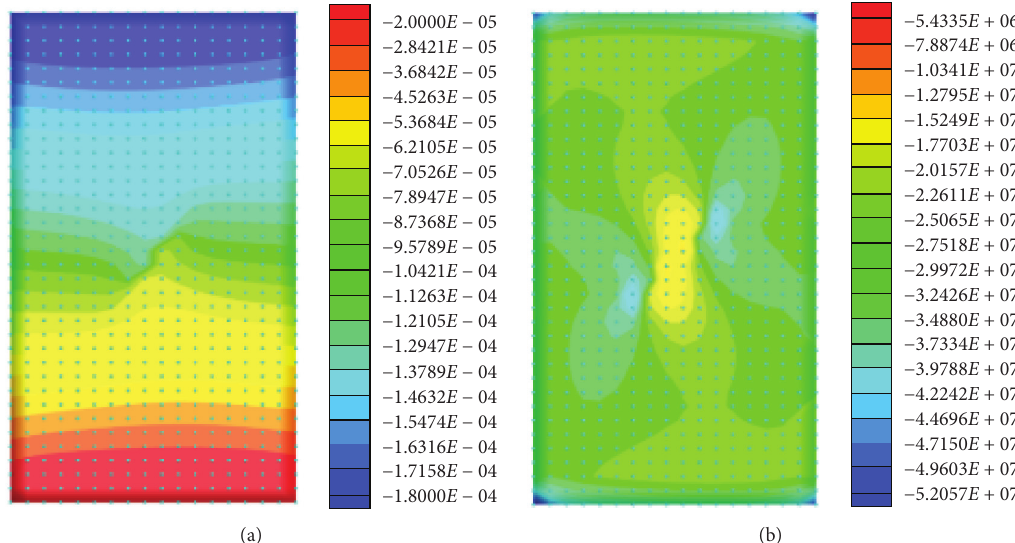
Figure 11: Nephogram of the model subjected to unidirectional compression. (a) Vertical displacement (m). (b) Vertical stress (Pa).